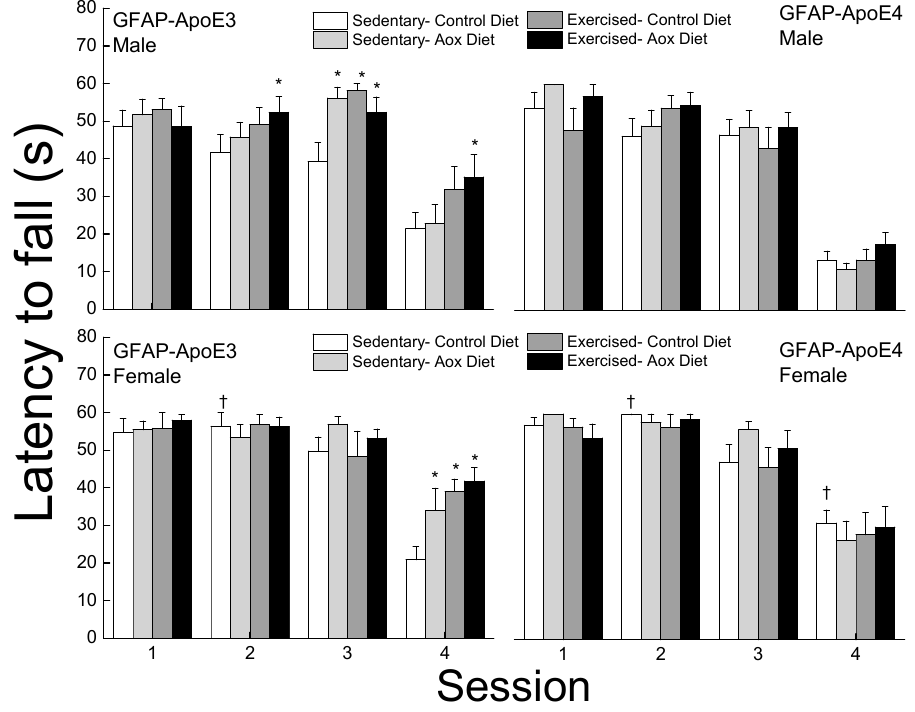
Figure 3. Exercise and antioxidants improved balance in male and female GFAP-ApoE3 mice but not in GFAP-ApoE4 mice. Each value represents mean ± SEM, n = 8–16. * p < 0.05 vs. sex- and strain-matched Sed-Con groups; † p < 0.05 comparing strain-matched Sed-Con males and